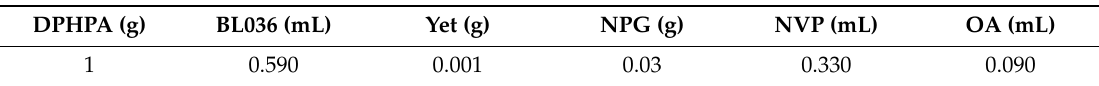
Table 1. Composition of the liquid solution for photopolymer holographic polymer dispersed liquid